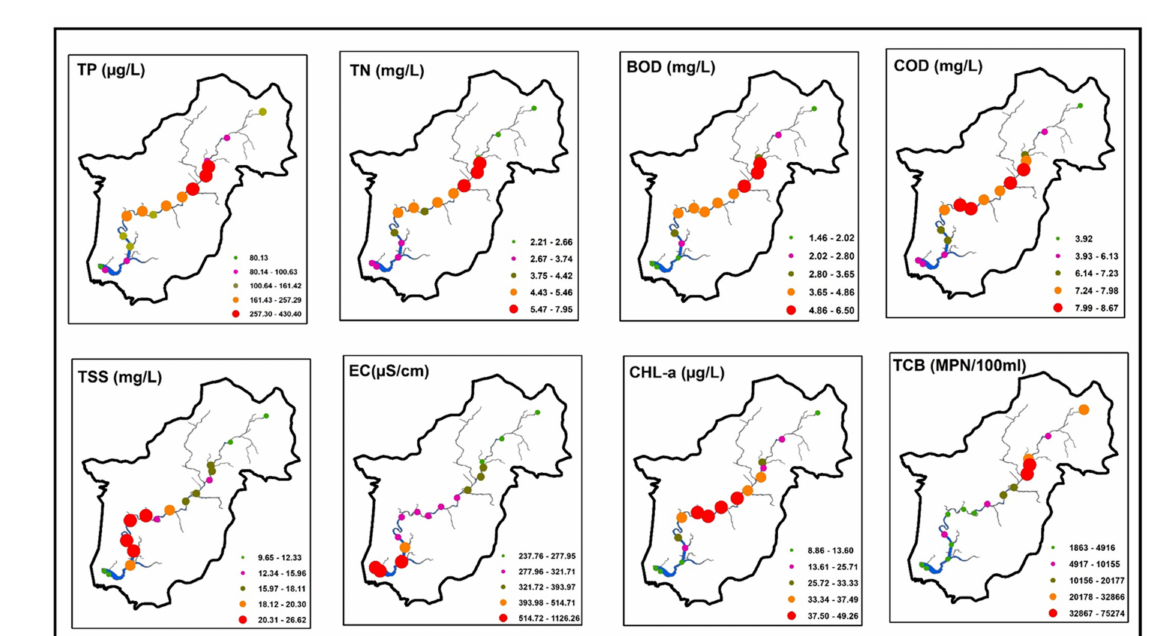
Figure 3. Spatial variations of water quality parameters (TP: total phosphorus; TN: total nitrogen; BOD: biological oxygen demand; COD: chemical oxygen demand; TSS: total suspended solids; EC: electrical conductivity; CHL-a: chlorophyll-a; TCB: total coliform bacteria). For site identification, please refer to Figure